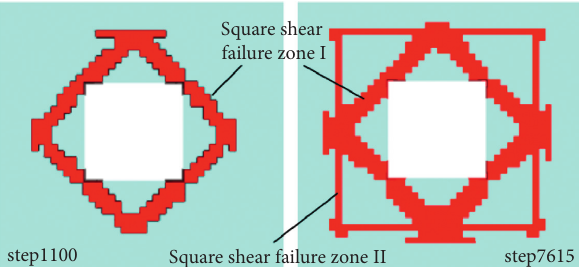
Figure 5: Evolution of main shear failure area of surrounding rock.